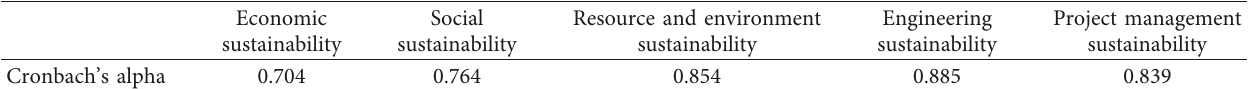
Table 5: Cronbach’s alpha.